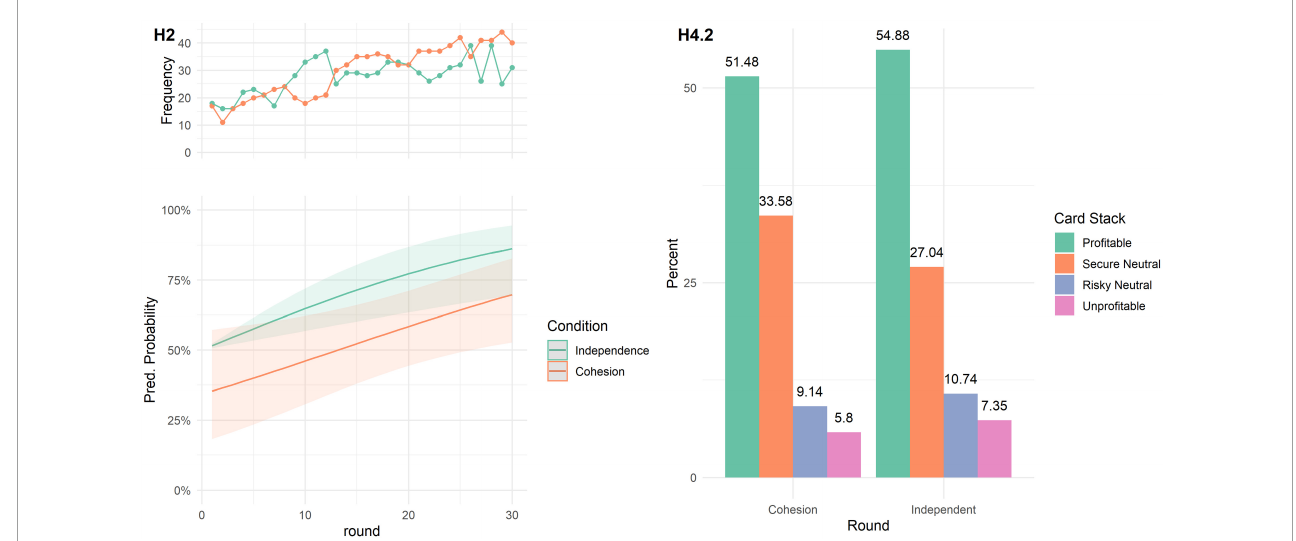
FIGURE3 (H2) Lower panel: Predicted probability of choosing the profitable card stack in each round. Lines represent the marginal effects, shaded areas represent the 95% C.I. Upper panel: Raw frequency of profitable card stack choices over rounds, separate for cohesion and independent condition. (H4.2) Relative frequency (percentage) of card stack choices, separate for cohesion, and independent